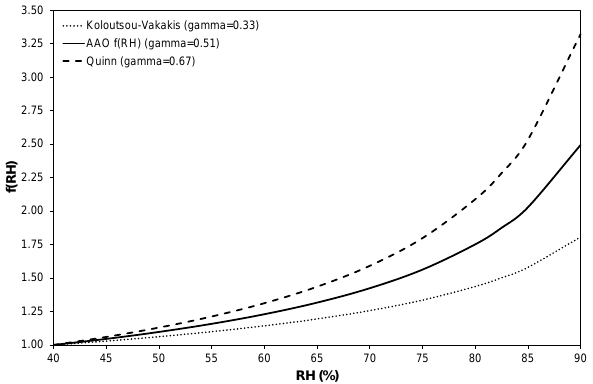
Fig. 8. Hygroscopic growth factor for light scattering, f (RH), for Koloutsou-Vakakis et al. (2001) parameterization, Quinn et al. (2005) parameterization, and the limited AAO f (RH) analysis.